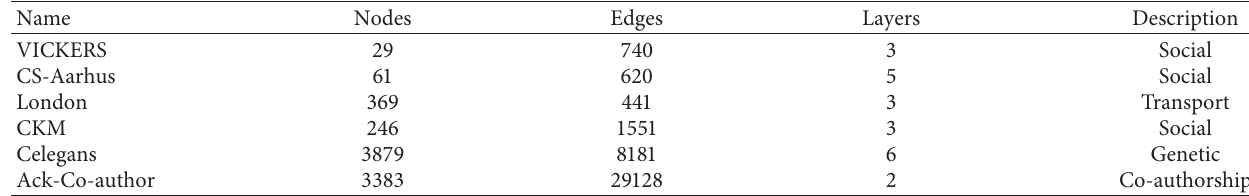
Table 1: Basic statistics about different multiplex networks used in this